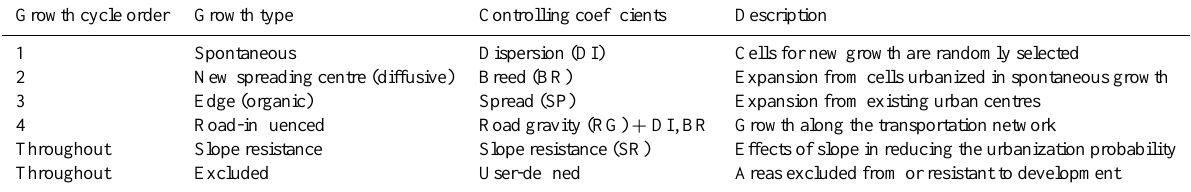
Table 1. Summary of growth types and controlling coefficients in SLEUTH (modified from Jantz et al., 2003 and Akın et al., 2014). Growth cycle